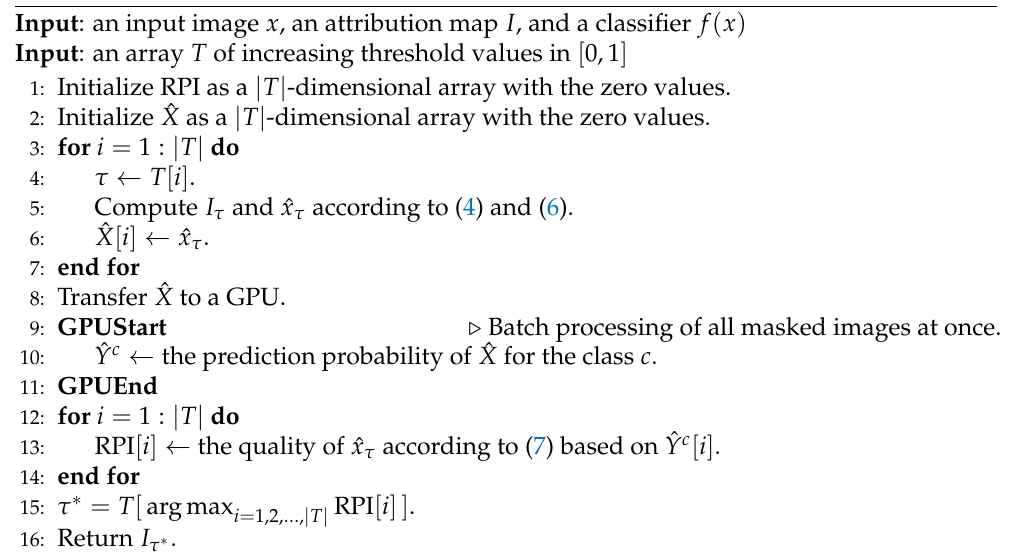
Algorithm 1 Threshold Fine-Tuning (TFT)